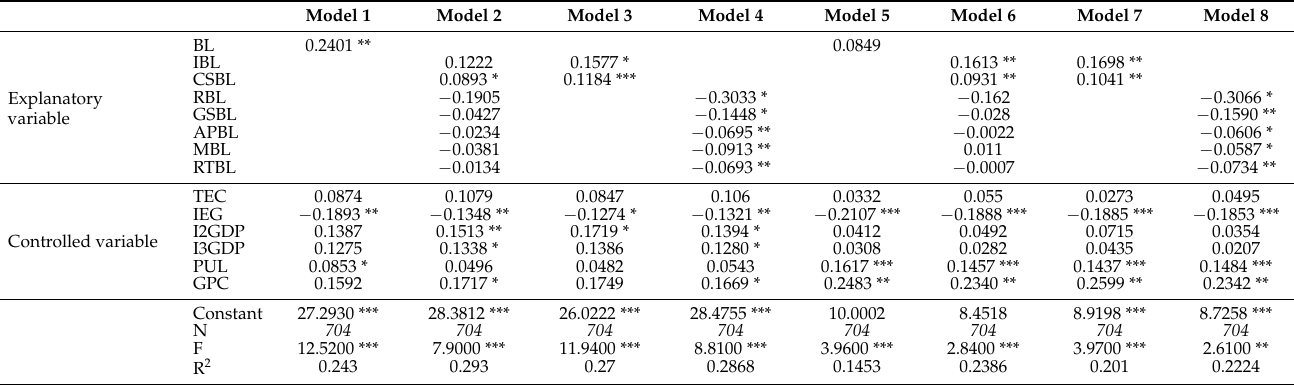
Table 3. Results of regression using the two-factor fixed effect